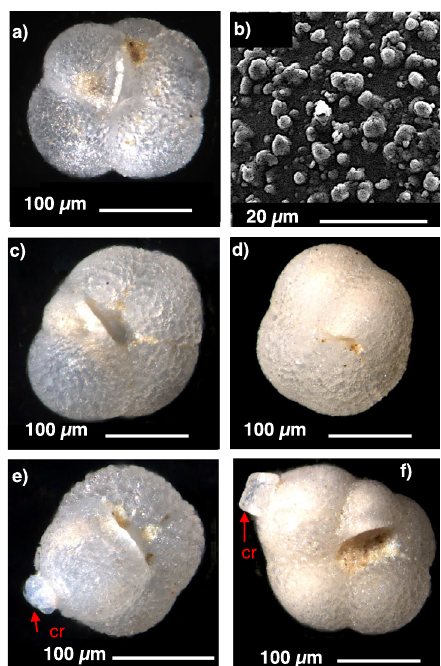
Fig. 4 Images on the classi fi cation of the preservation status of Neogloboquadrina pachyderma . a Pristine translucent PI_1 specimen. b Close-up view of primary shell showing smooth wall with low protuberances. c , d Specimens with no visible overgrowth PI_2. c Translucent-white specimen, d white specimen. e , f Specimen with visible overgrowth PI_3, both with distinct crystals, on translucent-white ( e ), and white shell ( f ). Specimen from core PS72/413-3. Core depth: a , b 6.5 cm; c , d 4.5 cm; e , f 11.5 cm. Stacked Axio Zoom images. cr =